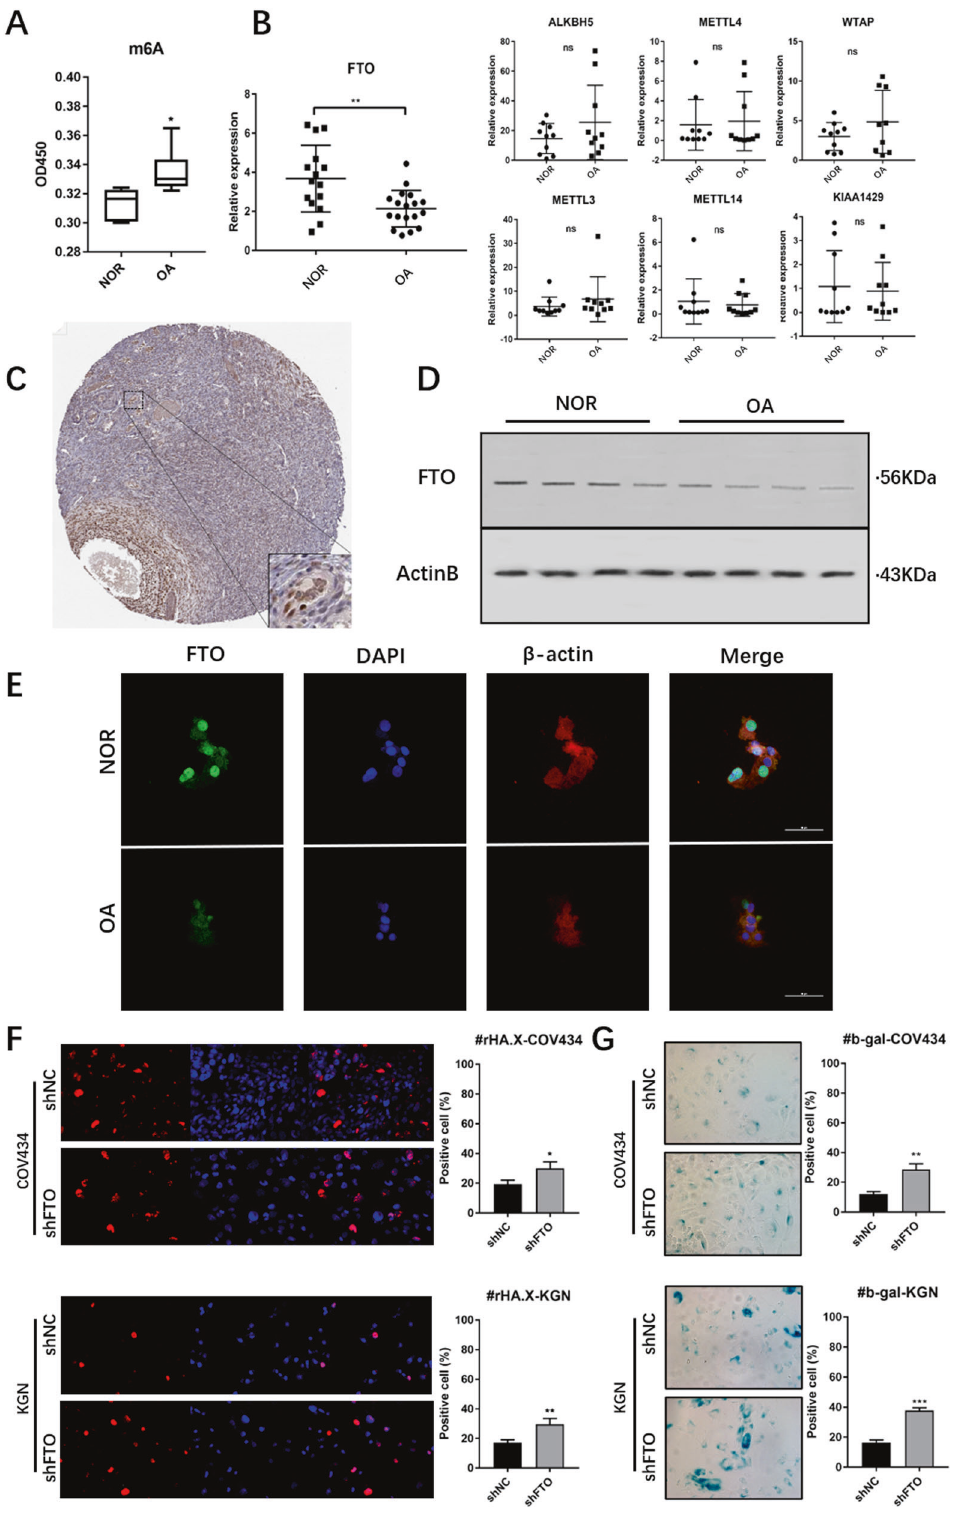
Fig. 1 Levels of RNA m6A and expression of FTO in GCs of OA patients and controls. A Increased m6A modi fi cation in GCs of aged ovary (OA) compared to the normal ovarian reserve group (NOR), n = 6. B RT-PCR shows the mean expression levels of m6A-associated genes in the GCs in OA and NOR; for FTO, n = 15; and for other genes, n = 10. C Immunohistochemistry (from www.proteinatlas.com) showed the speci fi c expression of FTO in granulosa cells of ovarian tissue. D , E Western blot and immuno fl uorescence analyses showing the downregulation of FTO in aged granulosa cells compared to young granulosa cells. F Immuno fl uorescence of γ H2A. X and G β -galactosidase staining in FTO- silenced KGN and COV434 cells more readily enter senescence induced by hydrogen peroxide. All experiments were performed three times. The error bars indicate SD; * p < 0.05, ** p < 0.01, *** p < 0.001.